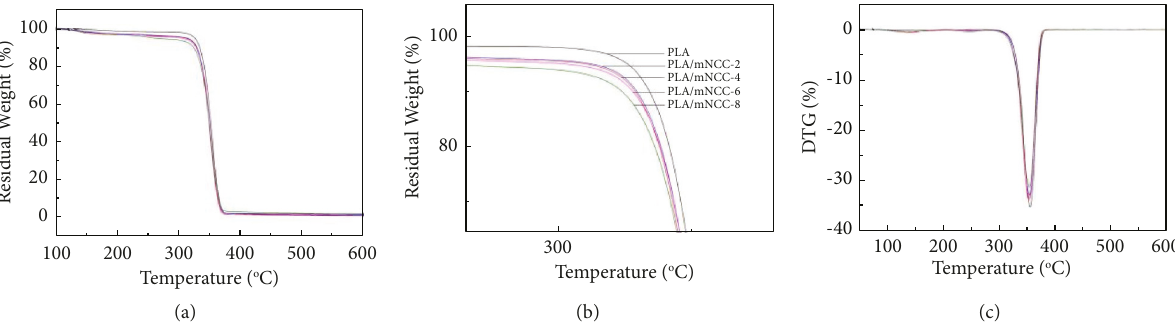
Figure 3: Thermal decomposition of the pure PLA and PLA nanocomposites at a heating rate of 10 ° C min − 1 under nitrogen.